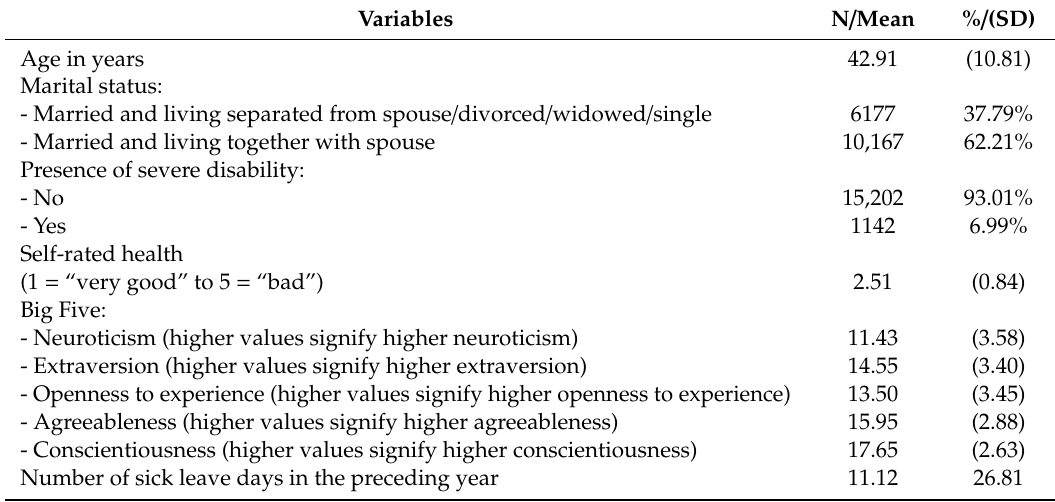
Table 1. Sample characteristics for individuals included in conditional fixed e ff ect logistic regressions ( n = 16,344; year 2005, 2009,